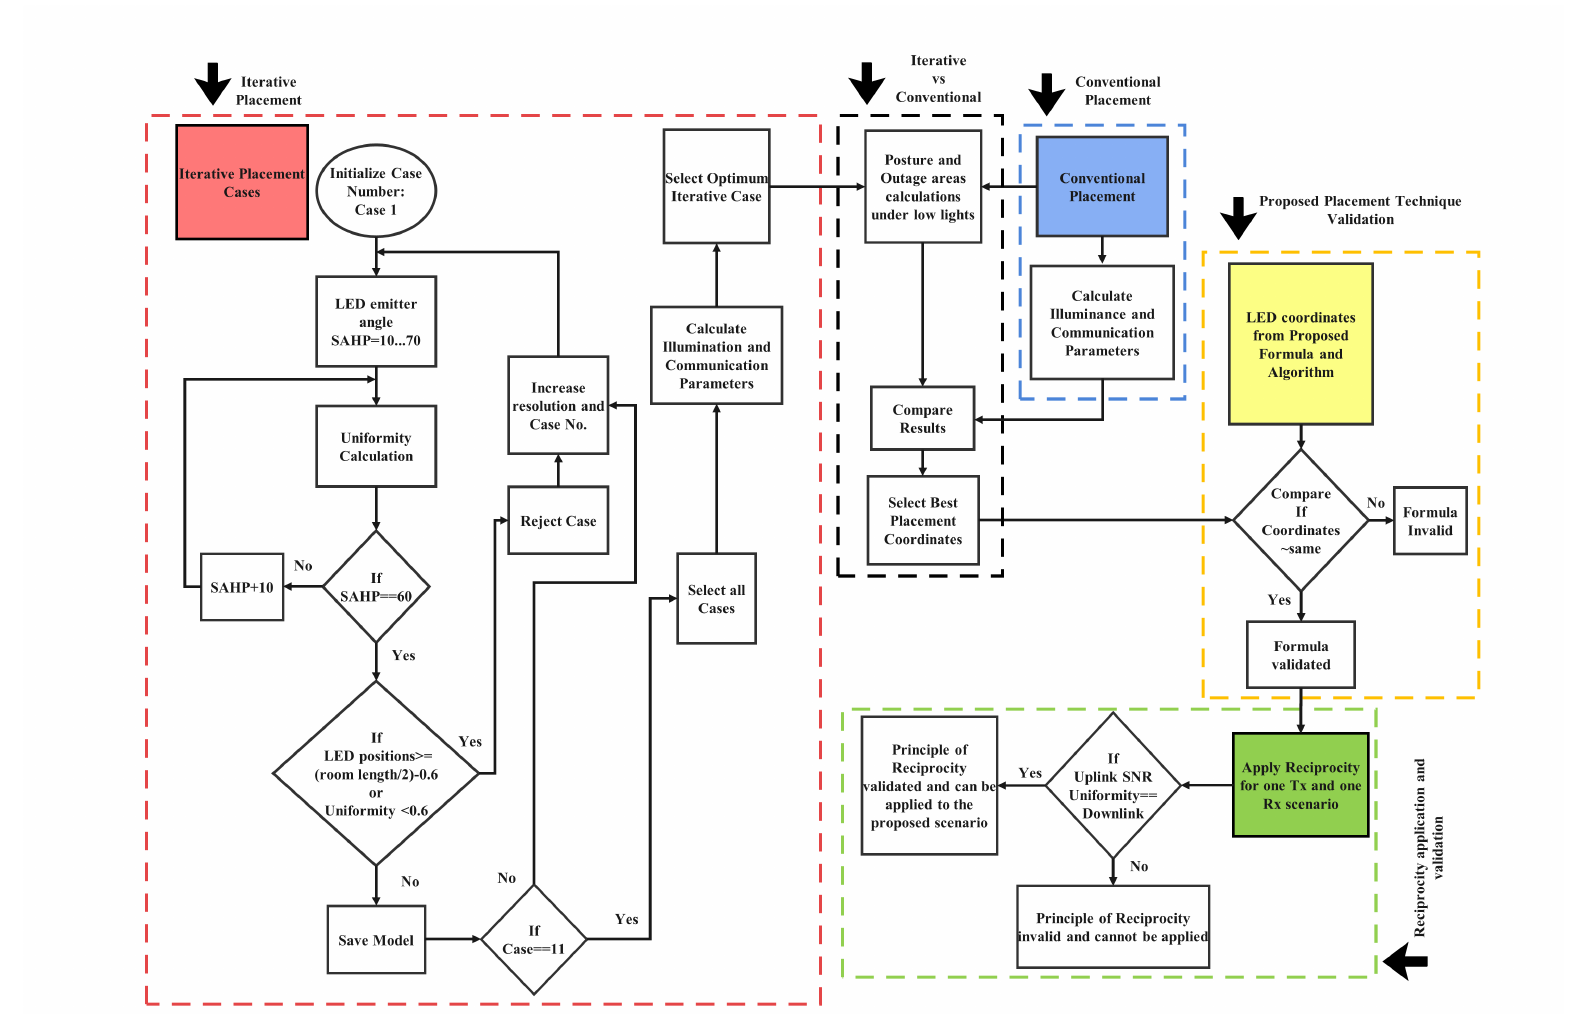
Figure 2. An overview of the Methodology adopted in this work to achieve signal-to-noise ratio (SNR) and illuminance